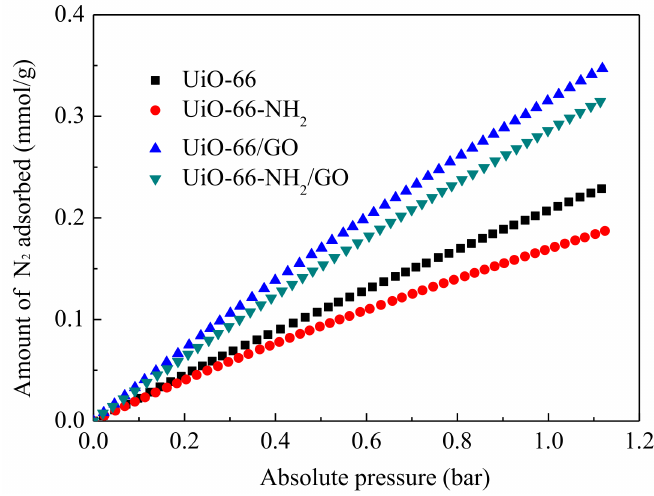
Figure 9. N 2 adsorption isotherms measured at 298 K on the